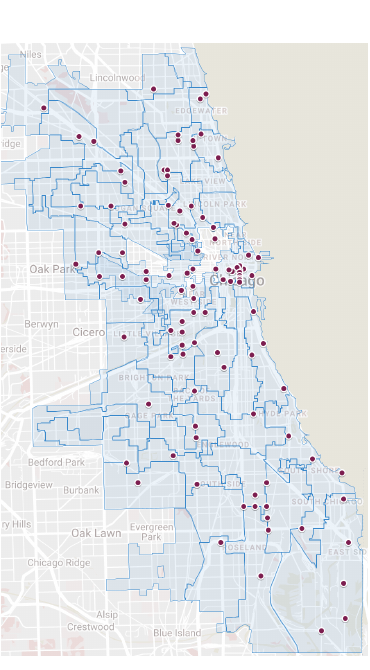
Fig. 1 Since 2016 over 250 AoT nodes have been installed, including upgrades to existing locations. Shown here are 130 nodes in Chicago as of 2020. Map created with Google